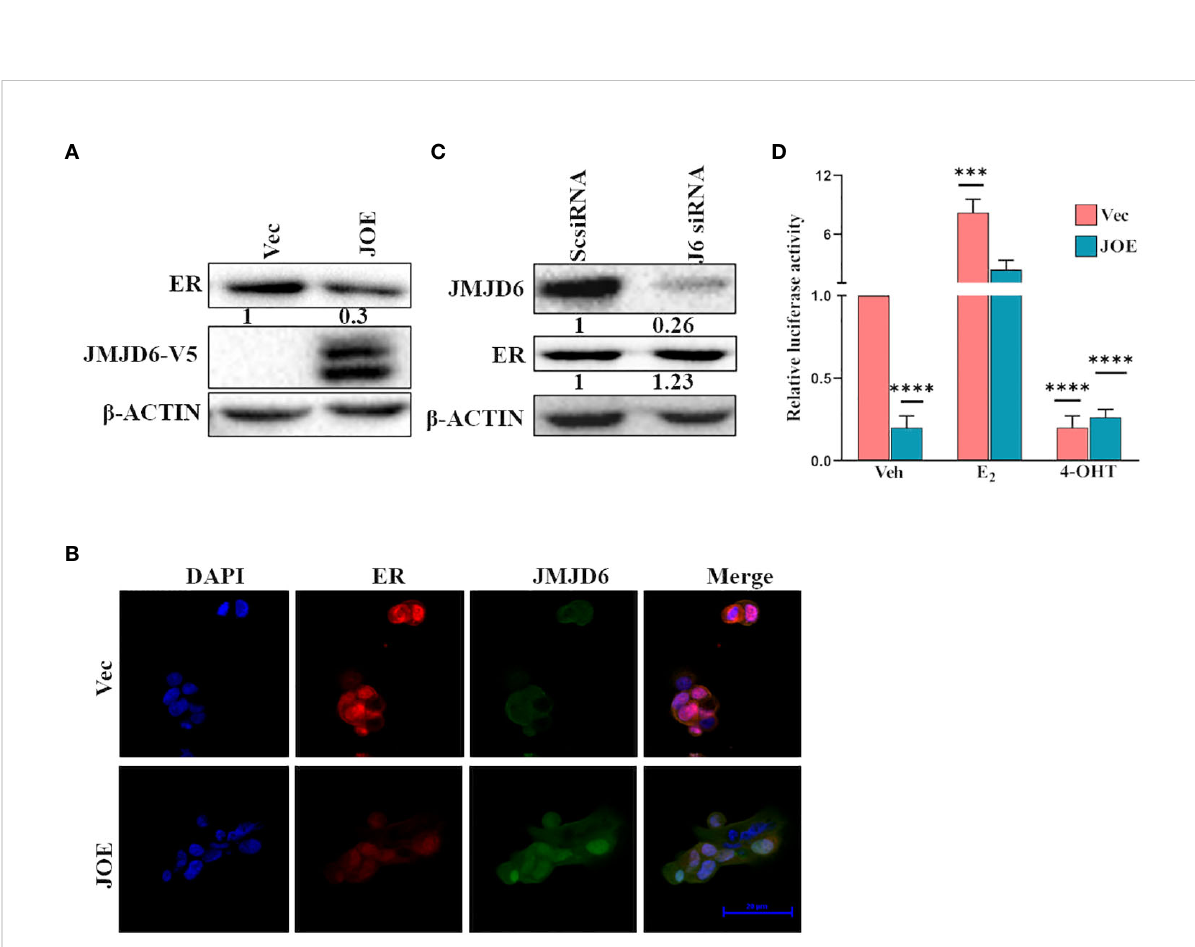
FIGURE 3 JMJD6 downregulates ER. (A) Immunoblot analysis of ER in JOE cells. b -Actin was used as internal control to demonstrate equal loading of proteins. Numbers below immunoblot panels represent densitometric scanning data plotted as a mean of three independent experiments. (B) Immuno fl uorescence staining of Vector and JOE cells using DAPI (blue), JMJD6 (green) and ER (red) and merged images (Scale bar, 20 m m). (C) Western blotting of ER protein after JMJD6 siRNA treatment of MCF7 cells (J6siRNA). Scrambled siRNA (ScsiRNA) was used as a control. Numbers below immunoblot panels represent densitometric scanning data plotted as a mean of three independent experiments. (D) ERE- Luciferase activity in JOE cells. The ratio of Fire fl y to Renilla luciferase activity in ethanol (Veh) treated Vec cells was normalized to 1 and fold change (FC) over Vec was calculated for all other samples. Data are representative of three independent experiments.